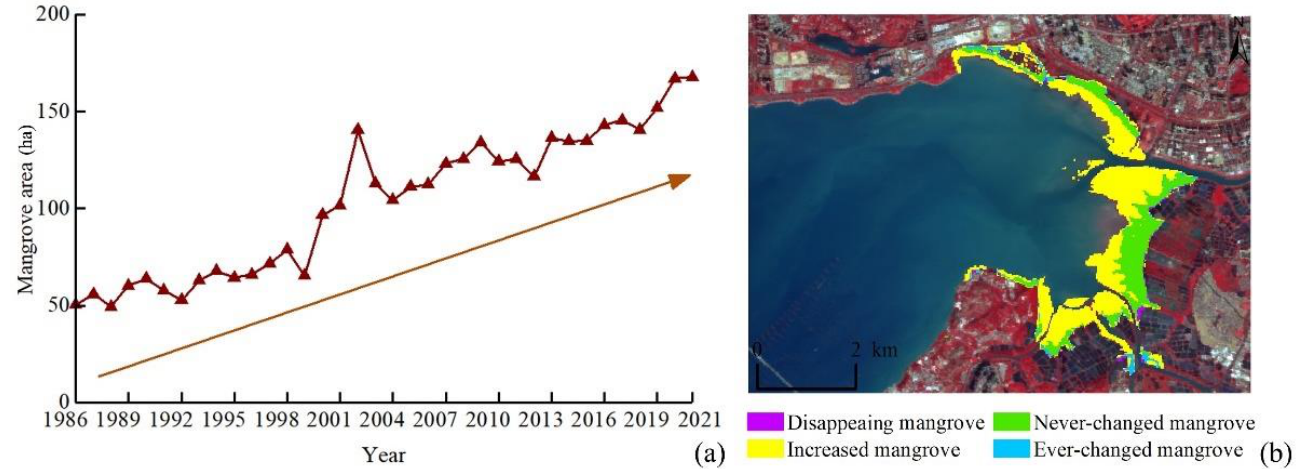
Figure 9. ( a ) Mangrove area of FMNR and ( b ) changes to mangroves in FMNR and MMNR during 1986 – 2021.